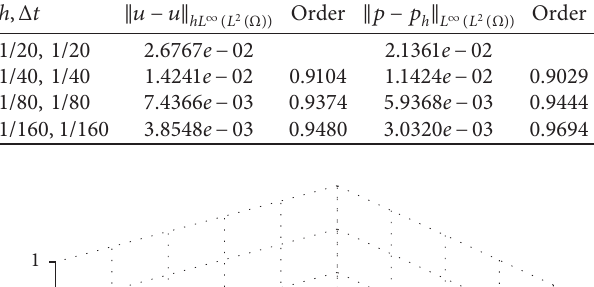
( x, t ) at t � 2 with h